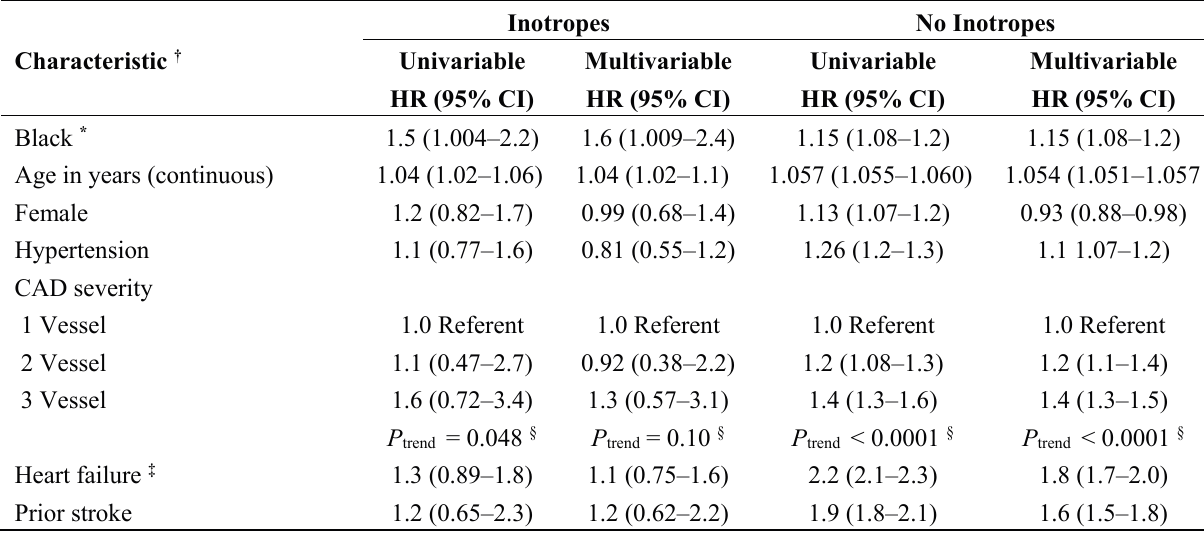
Table 4. Univariable and multivariable hazard ratios for